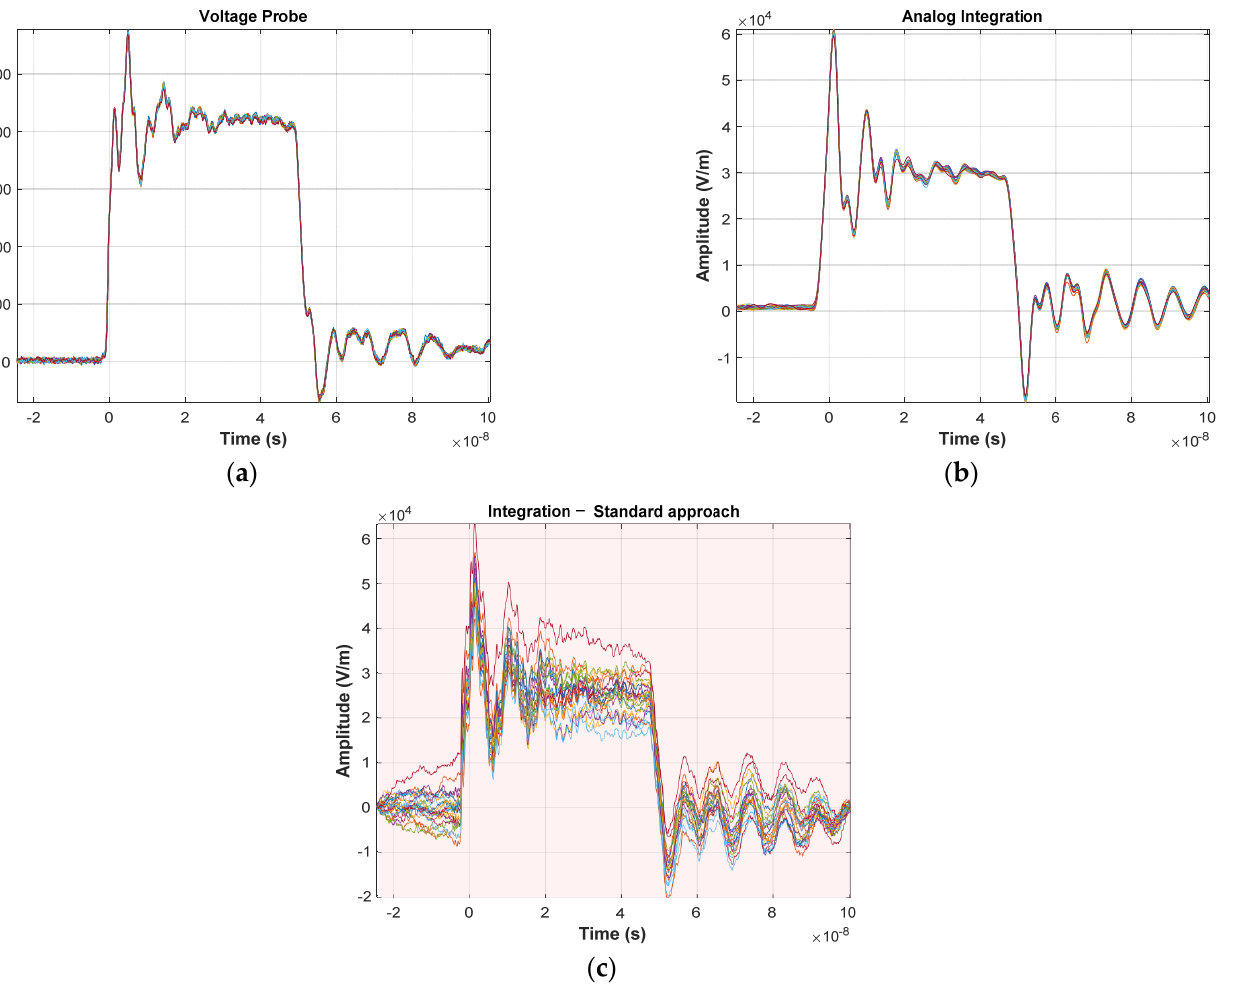
Figure 5. Measurement signals, ( a ) voltage probe, ( b ) electric field probe with analogue integration, ( c ) electric field probe with numerical integration.